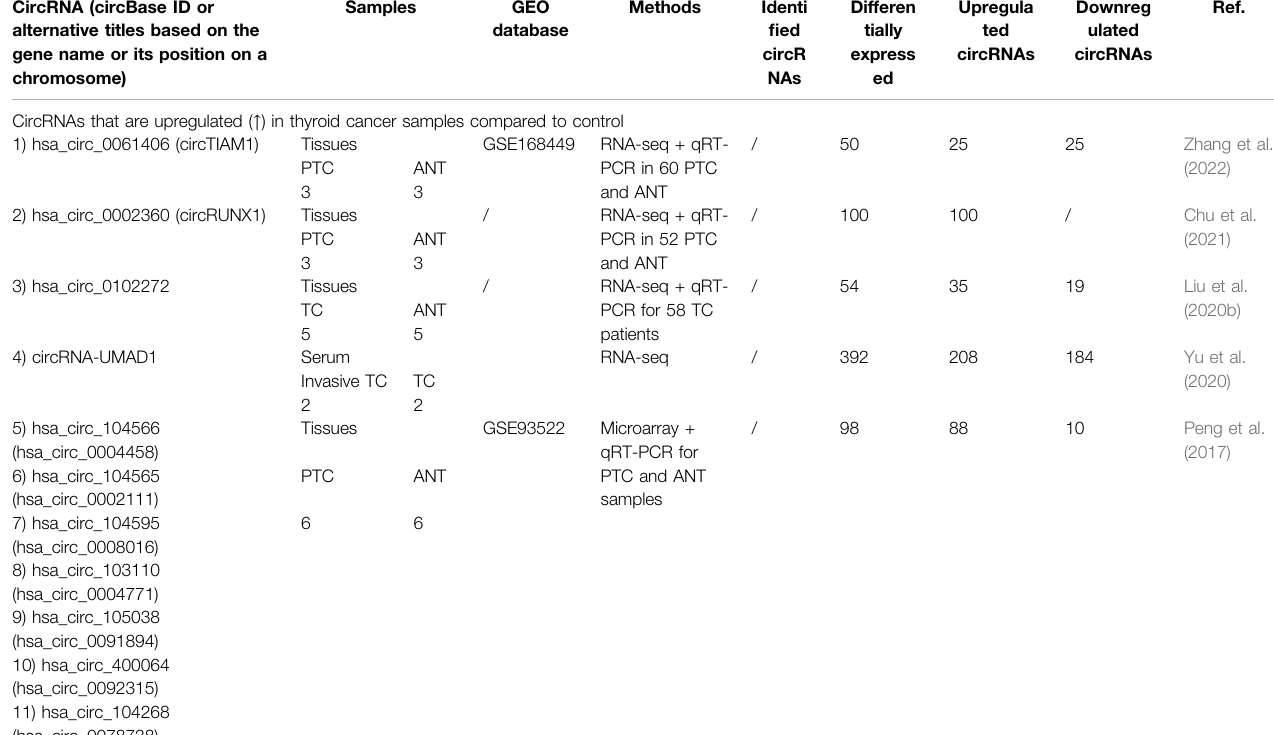
TABLE 1 | Expression pro fi ling of circRNAs in thyroid cancer. CircRNA (circBase ID or alternative titles based on